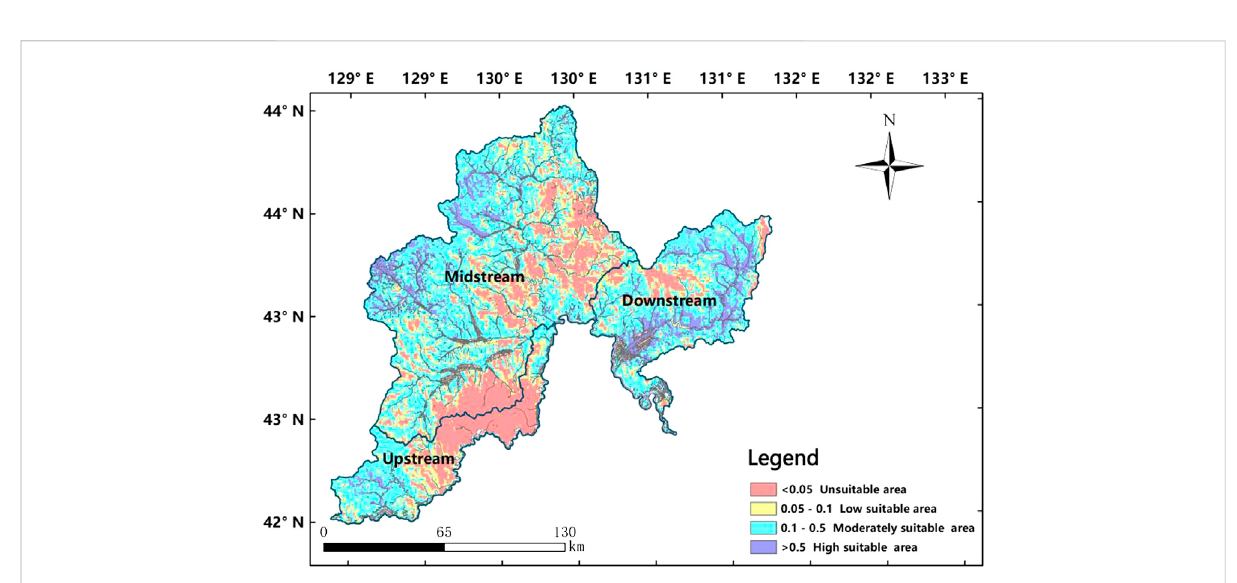
FIGURE 4 Distribution map of current ecological suitability of Deyeuxia